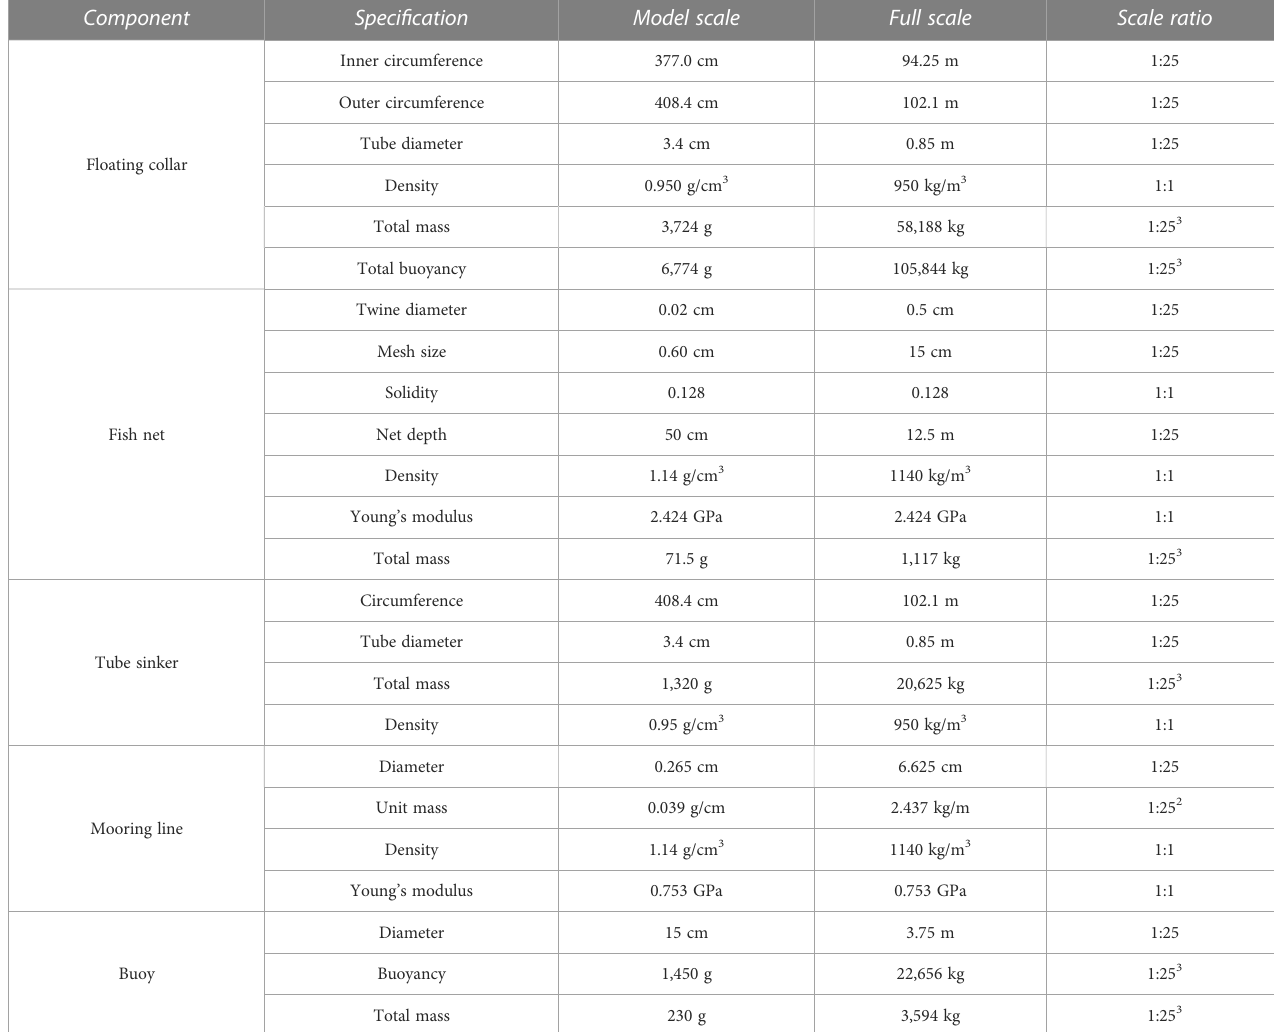
TABLE 1 Speci fi cations of the net cage model.